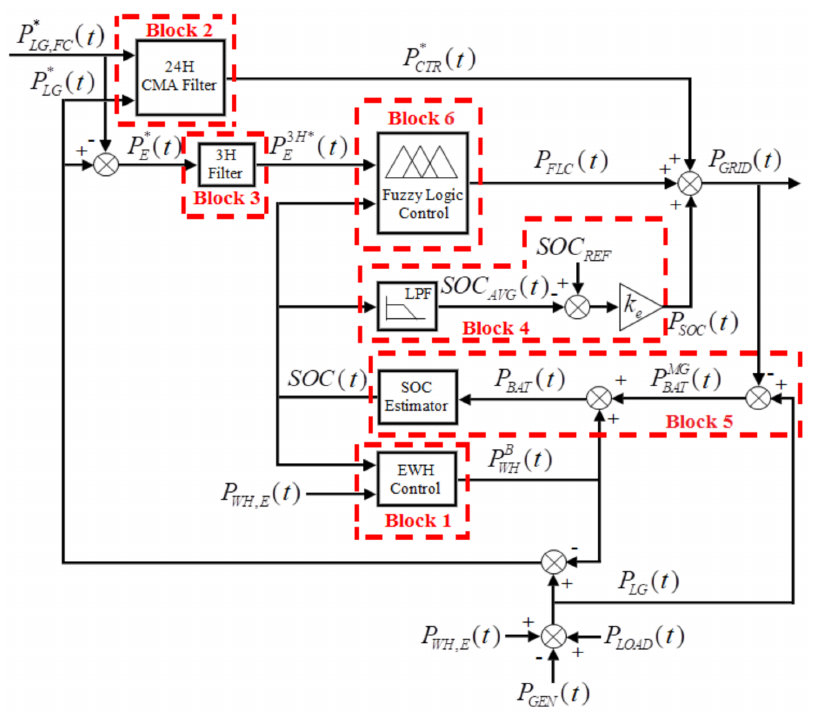
Figure 3. Energy management strategy block diagram [43]. ©2018 IEEE, Reprinted, with permission from D. Arcos-Aviles et al., “Fuzzy-based energy management of a residential electro-thermal microgrid based on power forecasting,” in IECON 2018—44th Annual Conference of the IEEE Industrial Electronics Society, Washington, DC, USA, October 2018, pp. 1824–1829.